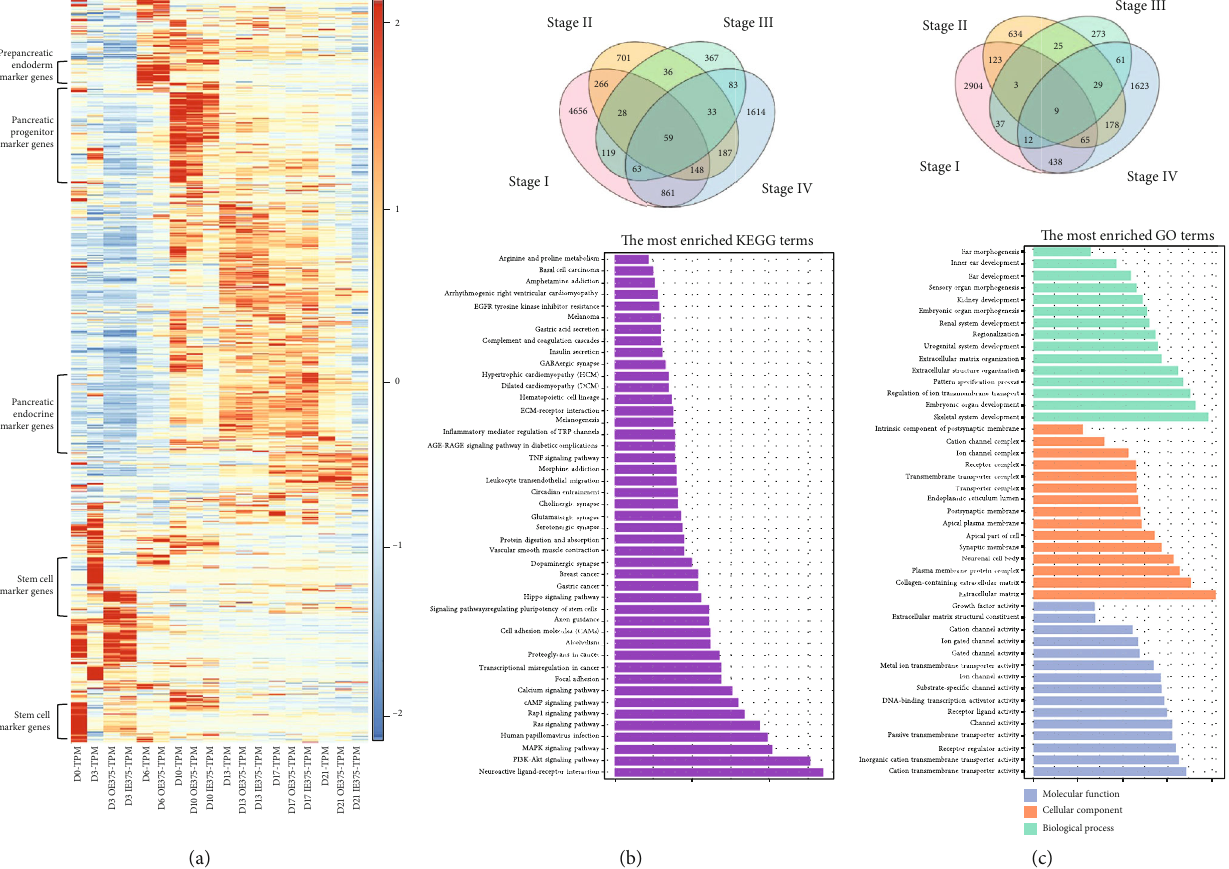
Figure 3: Overall description of di ff erentially expressed genes (DEGs) in the four di ff erentiation stages for control vs. miR-375 overexpression (OE) and control vs. miR-375 inhibition. (a) Heatmap showing the expression of DEGs in the miR-375OE group and the miR-375 inhibition group compared with the control group in di ff erent stages of di ff erentiation. Hierarchical clustering was used to cluster gene expression patterns, and its expression level was standardized to TPM. (b) Venn diagram showing the distribution of DEGs in the four stages of di ff erentiation in OE vs. control and bar plot showing the top 45 pathways of KEGG (Kyoto Encyclopedia of Genes and Genomes) enrichment, presented in descending order by gene number. (c) Venn diagram showing the distribution of DEGs in the four stages of di ff erentiation for IE vs. control and bar plot showing the top 15 pathways of three GO (gene ontology) terms: BP (biological process), CC (cellular component), and MF (molecular